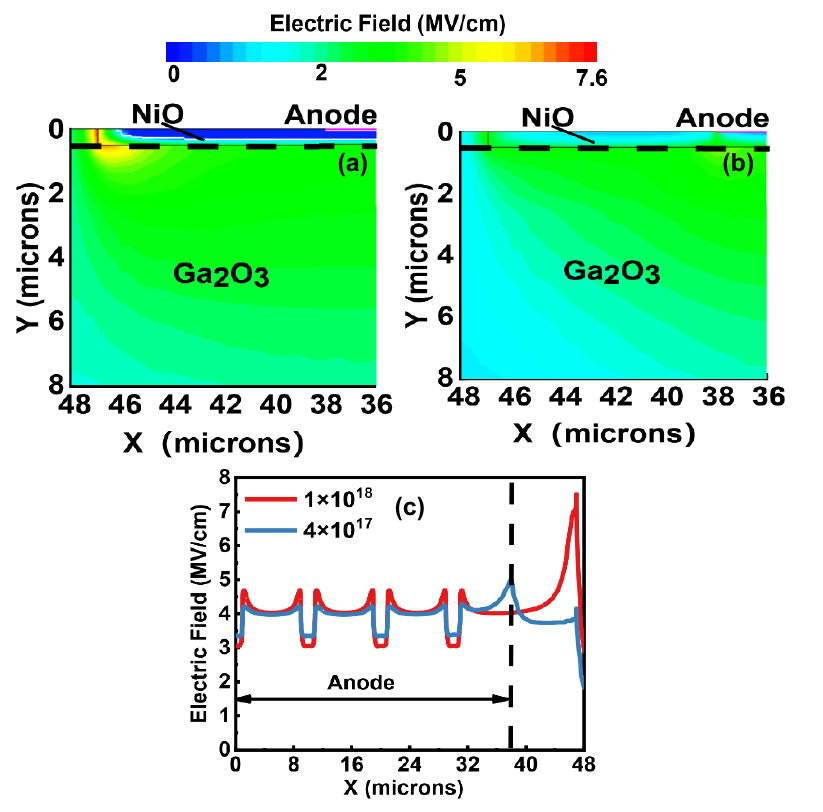
Figure 12. Electric field distribution in HJBS diode with the 8- µ m-width fin, the 2- µ m-width space, the doping concentration of ( a ) 1 × 10 18 cm − 3 and ( b ) 4 × 10 17 cm − 3 at reverse bias of − 3000 V. ( c ) Electric field versus position for HJBS diode along the cutline shown in the contour plots.